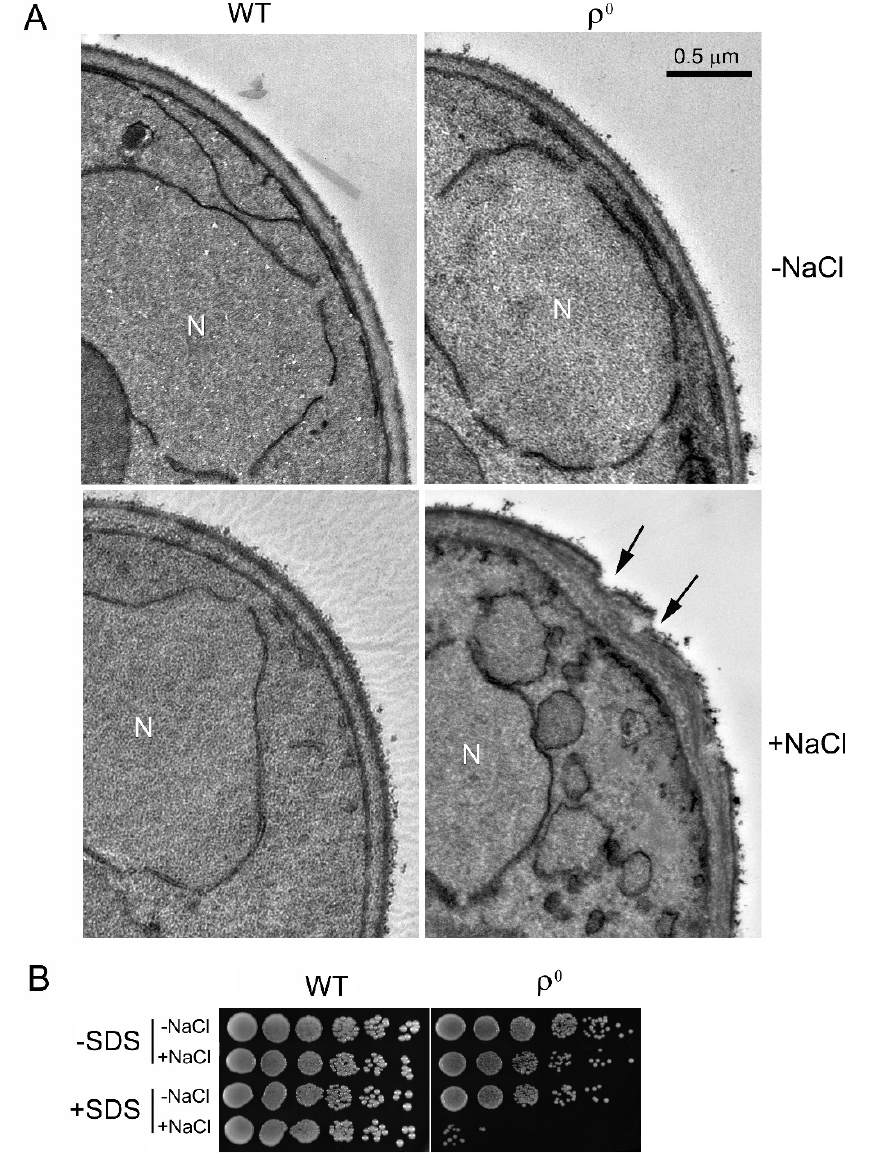
FIGURE 1: (A) TEM images of WT and ρ 0 cells growing in YPD medium with or without treatment of 0.6 M NaCl for 1 hr. A normal cell wall structure was observed in WT either with or without NaCl. The cell wall structure was damaged in ρ 0 cells upon NaCl treatment. Arrows indi- cate damaged cell wall. N = nucleus. (B) ρ 0 cells are hypersensitive to SDS after NaCl treatment. Cells were first grown in YPD liquid media con- taining 0.6 M NaCl for 1 hr, then washed, treated with 0.1% SDS for 0.5 hr, spotted on YPD plates using 4 μl of 1:5 serial dilutions and incu- bated for 2-3 days at 30 ο